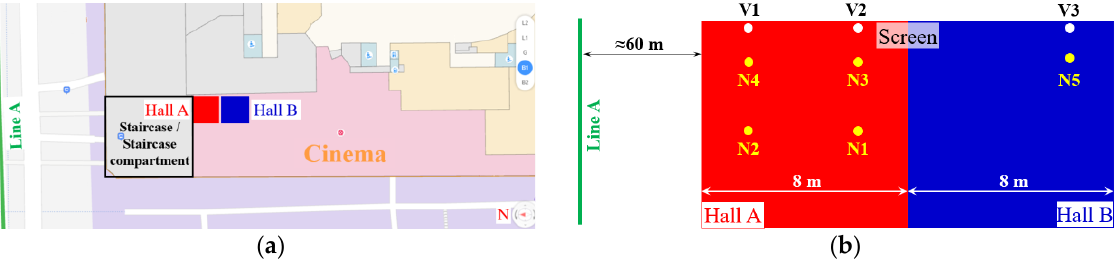
Figure 20. Schematic diagram of the relative location between cinema halls and metro Line A ( a ) and the test points set up ( b ).